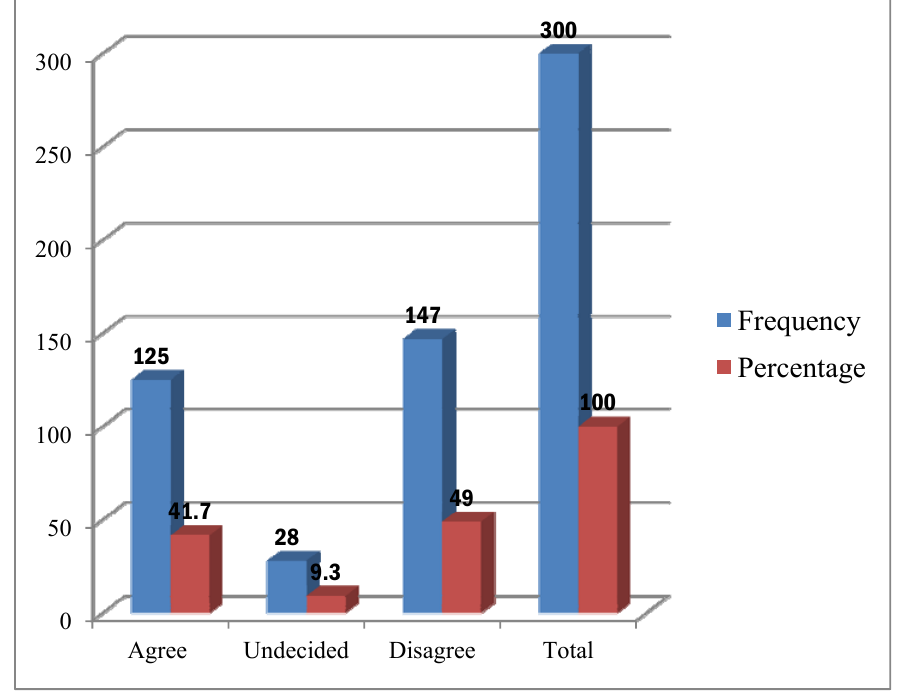
Bar Chart 5: Represents the opinion of respondents on whether ministries adheres to merit as guiding principles in selecting officers for training and